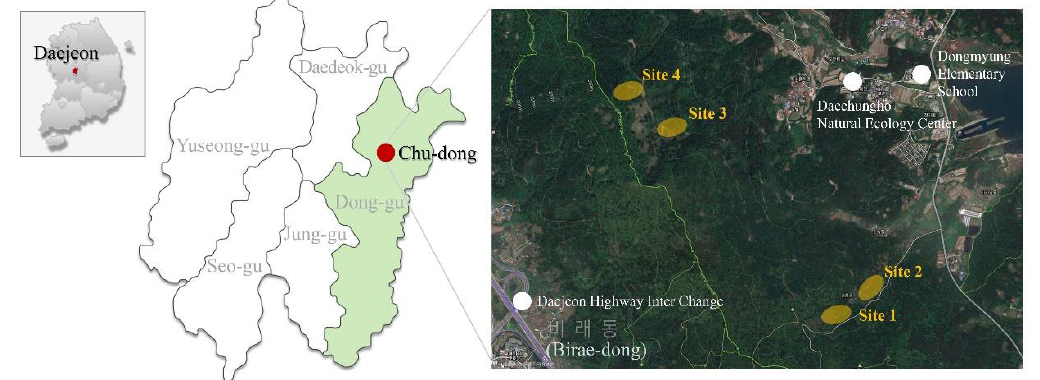
Figure 1. The location of the study area and experimental sites.